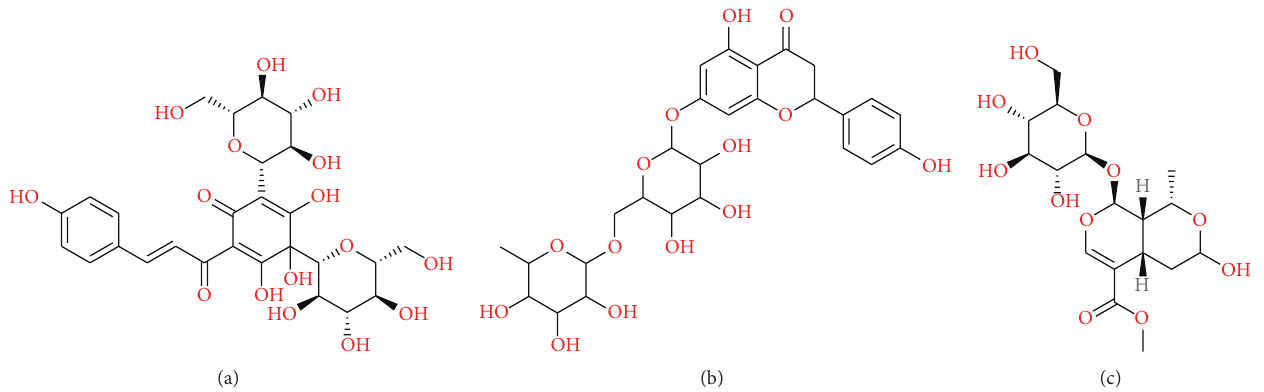
Figure 3: Structure of natural components: (a) Hydroxysafflor yellow A, (b) Naringin, and (c) Morroniside.